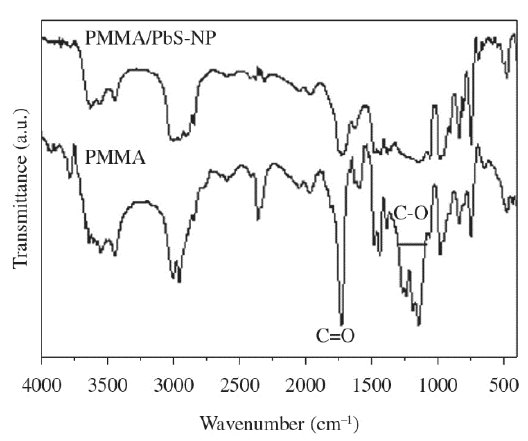
Figure 5. FT-IR spectra of PMMA-control and PMMA/PbS-NP films.